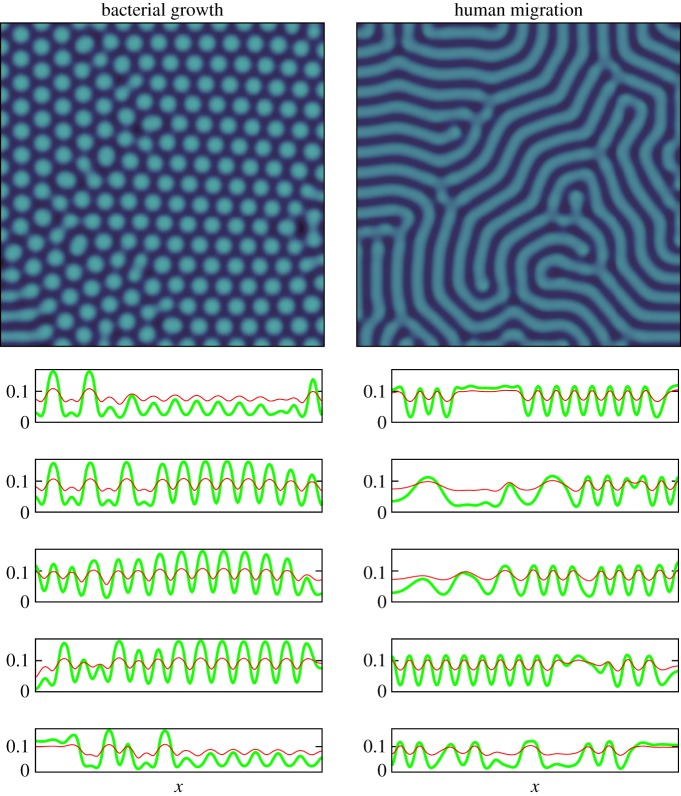
Density profiles at a given y. At a given pattern in each column, we horizontally slice along the x-axis at different points such as y = 271, 211, 141, 71 and 10 (from top to bottom) to show defector and cooperator densities. This gives us the densities u and v corresponding to regions near the domain boundaries (272,10), centre (141) and intermediate positions (211,71). The left (right) column is for bacterial growth (human migration) case. Cooperator and defector densities are represented by thick green and thin red coloured lines, respectively.